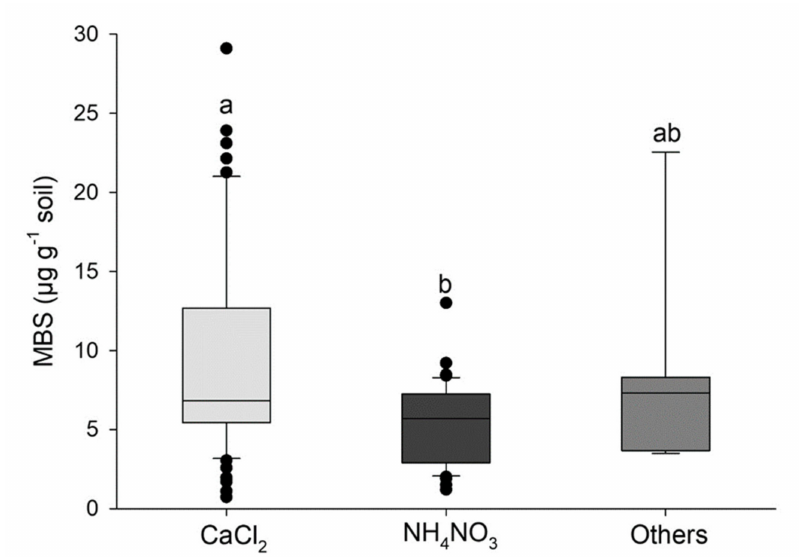
Figure 3. MBS contents extracted with 10 mM CaCl 2 ( n = 75), 1 M NH 4 NO 3 ( n = 45), and other extractants ( n = 9: 8 mM Ca(H 2 PO 4 ) 2 = 1; 0.1 M NaHCO 3 = 2; 16 mM KH 2 PO 4 = 2; 0.5 M KCl = 2; 16 mM NaH 2 PO 4 = 2); different letters on top of outliers or whisker caps indicate a